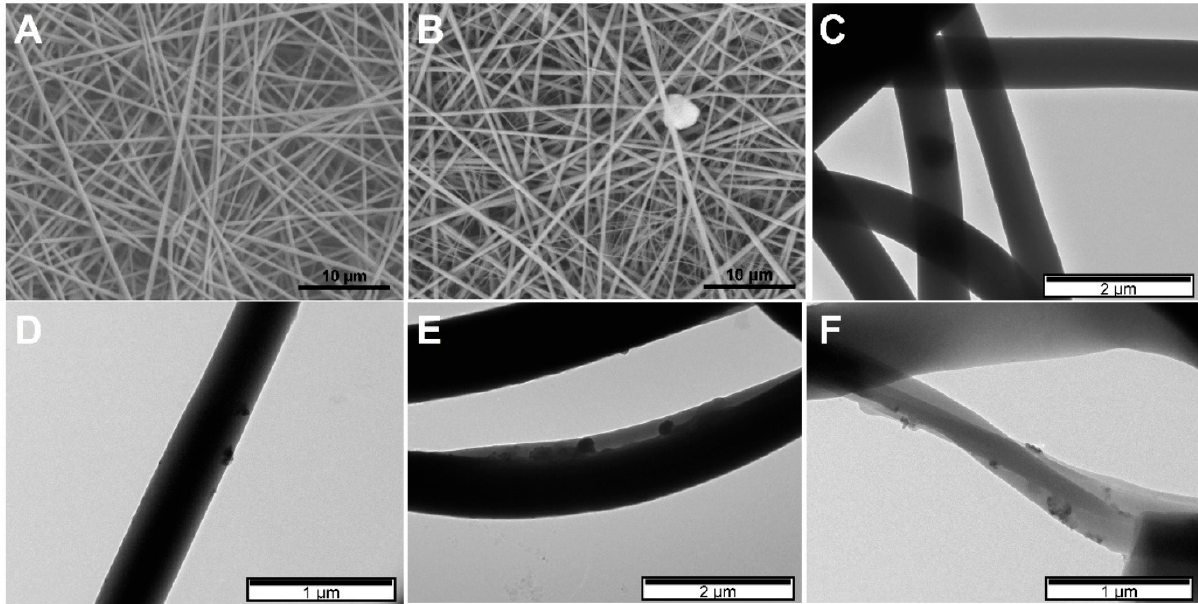
Figure 5. SEM image of bare polyvinylpyrrolidone (PVP) membrane ( A ), and PVP membrane containing PNIPAAm microgels ( B ). Scale bar corresponds to 10 μ m. ( C ) TEM image of PVP electrospun fibers containing plain PNIPAAm MG, PNIPAAm MG with bare Fe 3 O 4 NPs ( D ), PNIPAAm MG with Fe 3 O 4 -OA NPs ( E ), and PNIPAAm MG with Fe 3 O 4 -DMSA NPs ( F ).